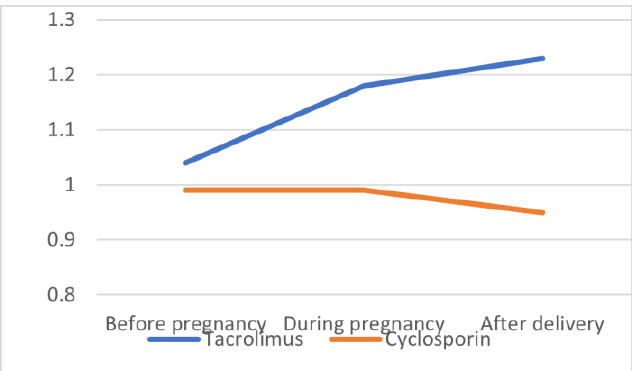
Figure 1. Serum creatinine concentration (mg/dL) before, during, and after pregnancy in patients on tacrolimus-based and cyclosporine-A-based immunosuppressive regimens. We also analyzed serum association between serum creatinine concentration and biochemical serum markers expressed as MoM values in kidney graft recipients. The free β-hCG MoM values positively correlated with serum creatinine levels before (r = 0.653; p < 0.001), during (r = 0.619; p = 0.001), and after pregnancy (r = 0.697; p < 0.001). For PAPP-A MoM values, we found a statistically significant negative correlation only for postpartum serum creatinine concentration (r = −0.424, p = 0.035). In the study group, PAPP-A MoM